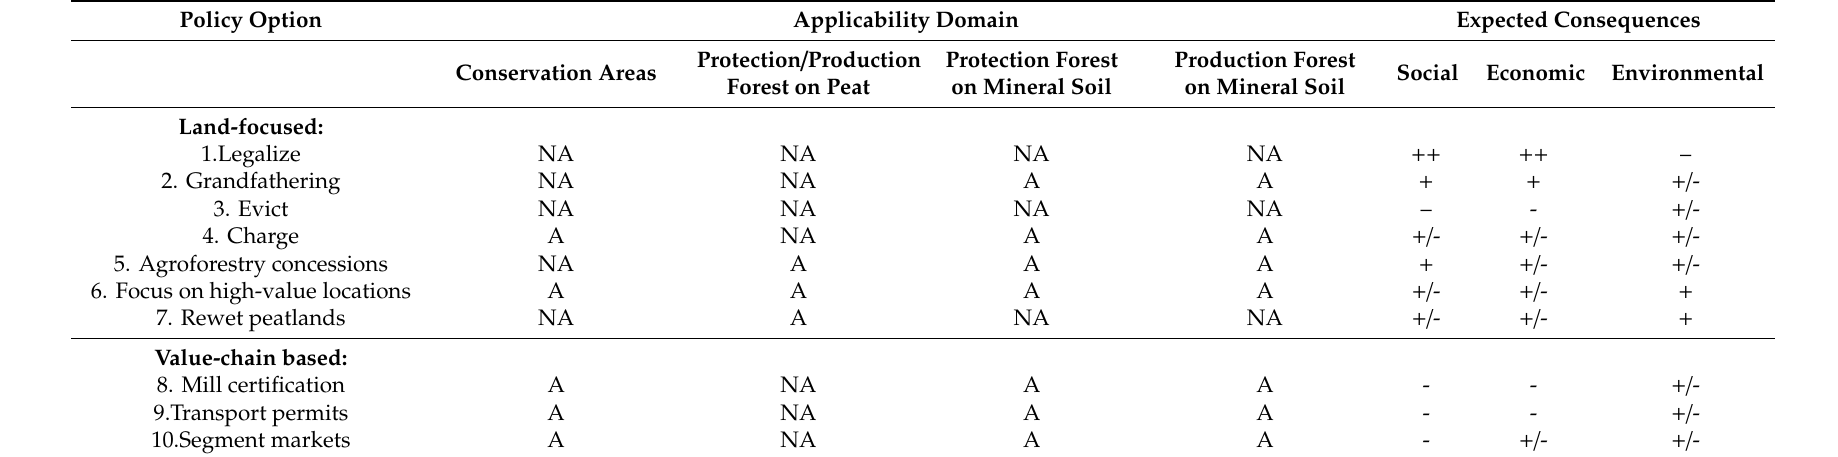
Table 5. Policy options to deal with oil palm within the forest zone, by applicability domain. Policy Option Applicability Domain Expected Consequences Protection / Production Protection Forest Production Forest Conservation Areas Social Economic Forest on Peat on Mineral Soil on Mineral Soil